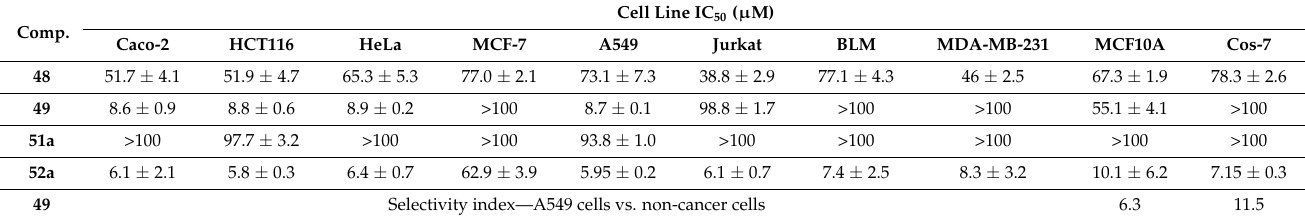
Table 1. The inhibitory concentrations IC 50 (μM) of tested compounds in different cell lines after 72 h incubation.